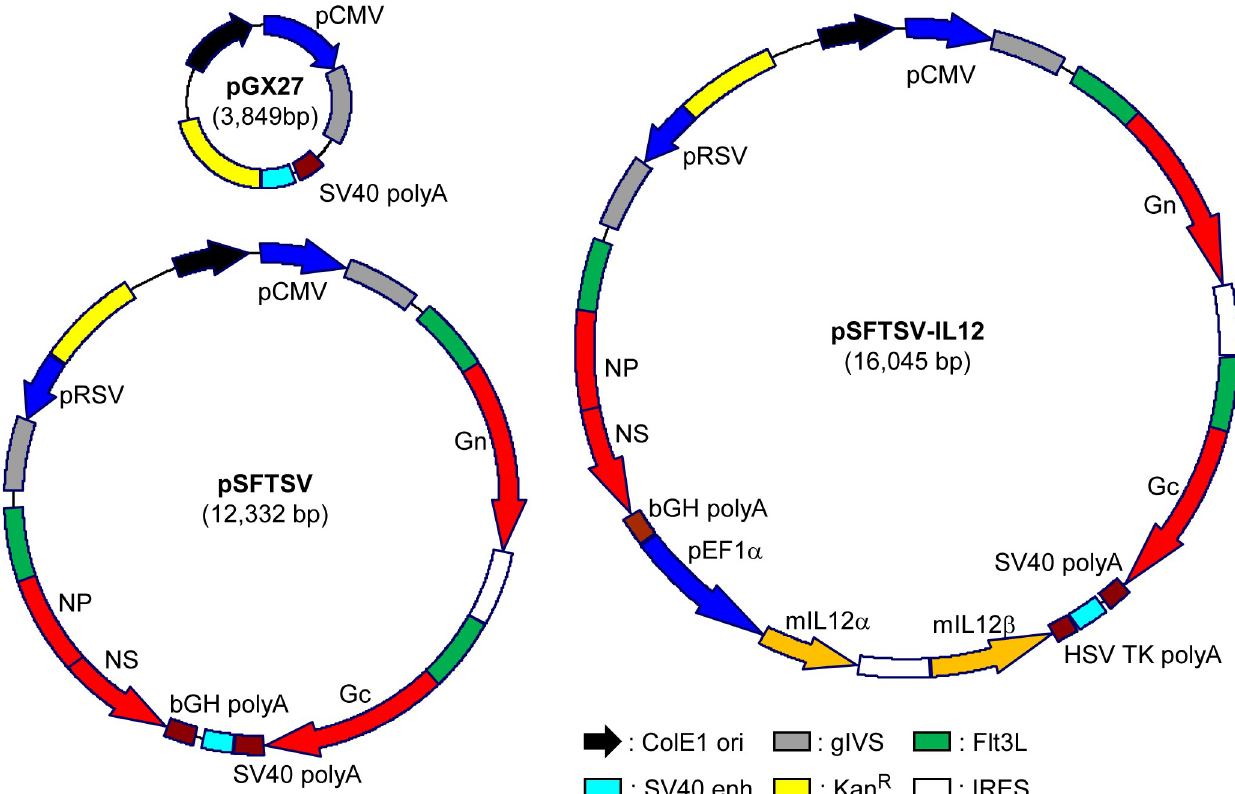
Fig 1. Schematic diagrams of SFTSV DNA vaccines used in this study. pSFTSV was constructed by inserting genes encoding ectodomains of Gn and Gc, and NP-NS fusion protein into the pGX2 vector. The viral antigens are preceded by the secretory signal sequence of tPA and the extracellular domain of Flt3L. pSFTSV-IL-12 includes additional genes encoding murine IL-12 α and β to promote cellular immunity. ColE1, ColE1-type bacterial origin of replication; gIVS, rabbit β -globin intervening sequence; Kan R , kanamycin resistance gene; IRES, internal ribosome entry